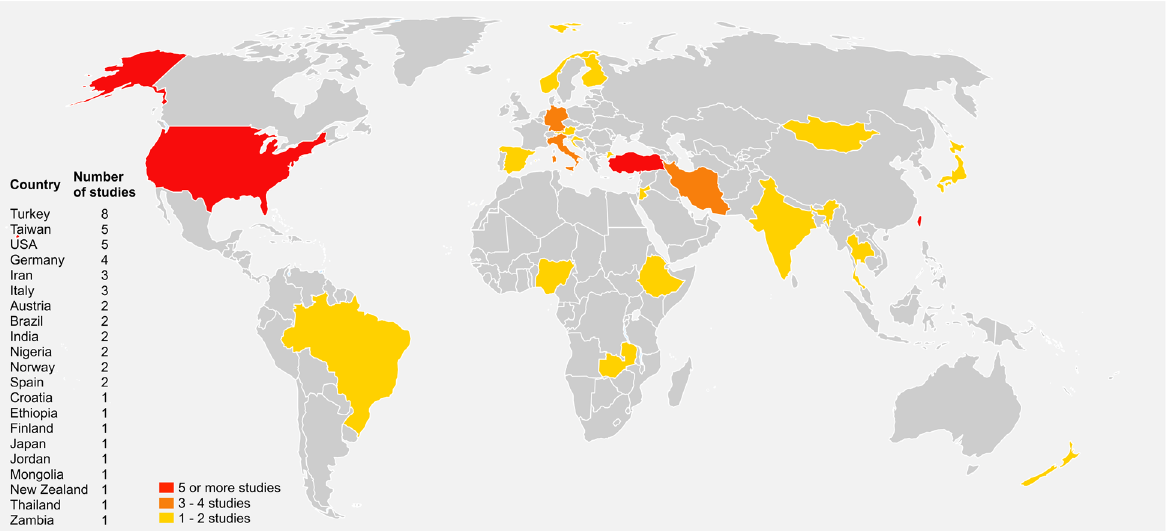
Fig. 2 Graphic national representation of the population samples included in each study. Red—Countries reporting 5 or more prevalence studies; Orange—Countries reporting up to 4 prevalence studies; Yellow—Countries reporting up to 2 prevalence